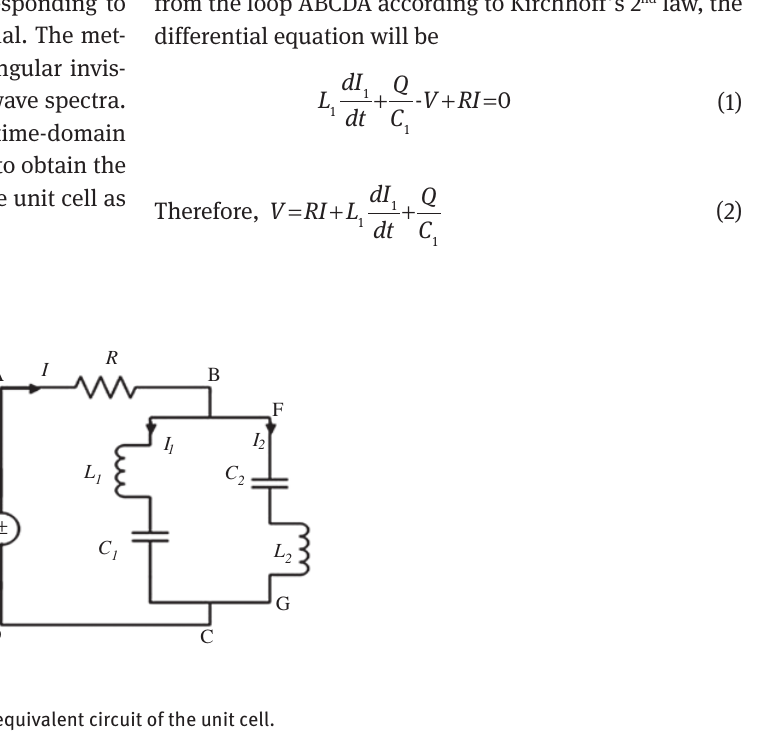
Figure 1: (A) The proposed unit cell structure and (B) equivalent circuit of the unit